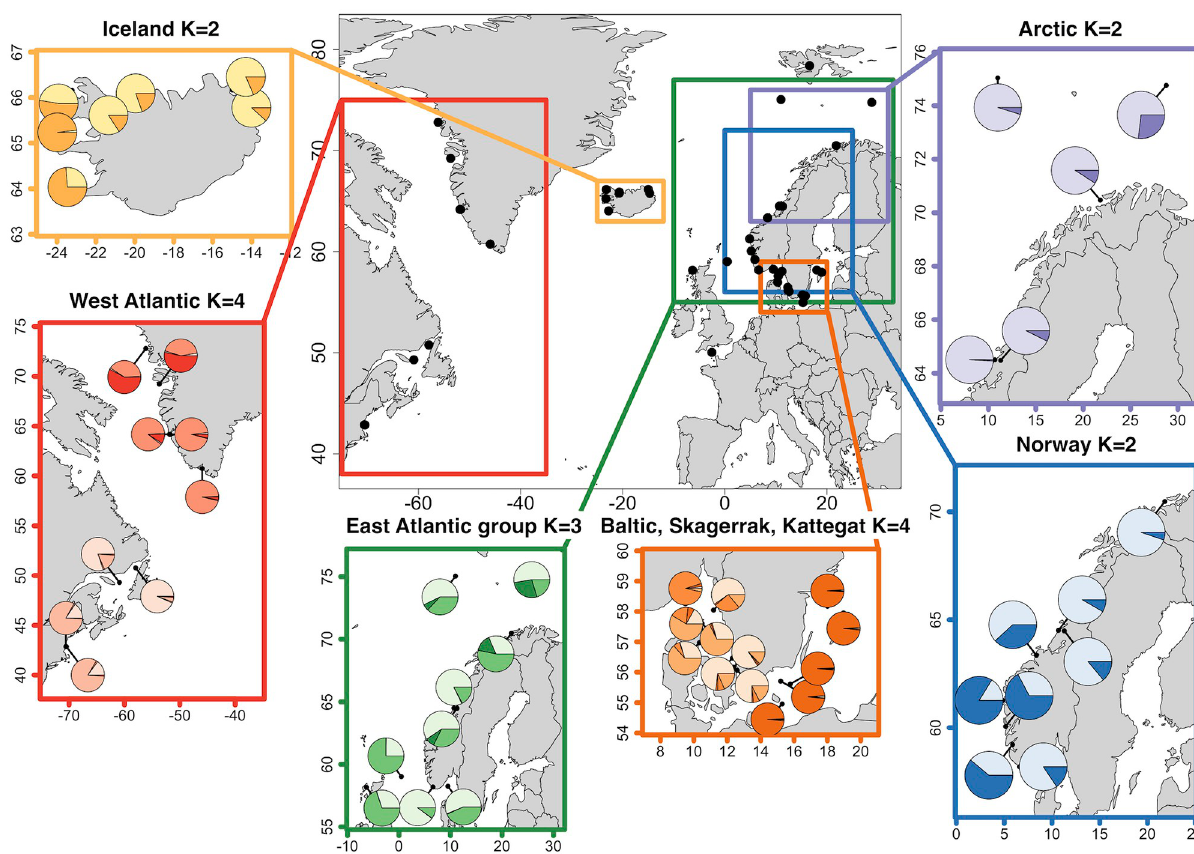
Fig 4. Regional STRUCTURE assignment of lumpfish ( Cyclopterus lumpus ) based on targeted 139 SNPs. Square represents separate structure runs for different regions where a set of samples, which due to their genetic and geographic closeness were analyzed together. Each pie chart shows one sample’s assignment to the selected number of clusters ( K ) averaged across individuals. Note that some of the samples are included in multiple assignments but that Isfjorden and the English Channel samples were not included in any regional structure analysis due to their uniqueness.